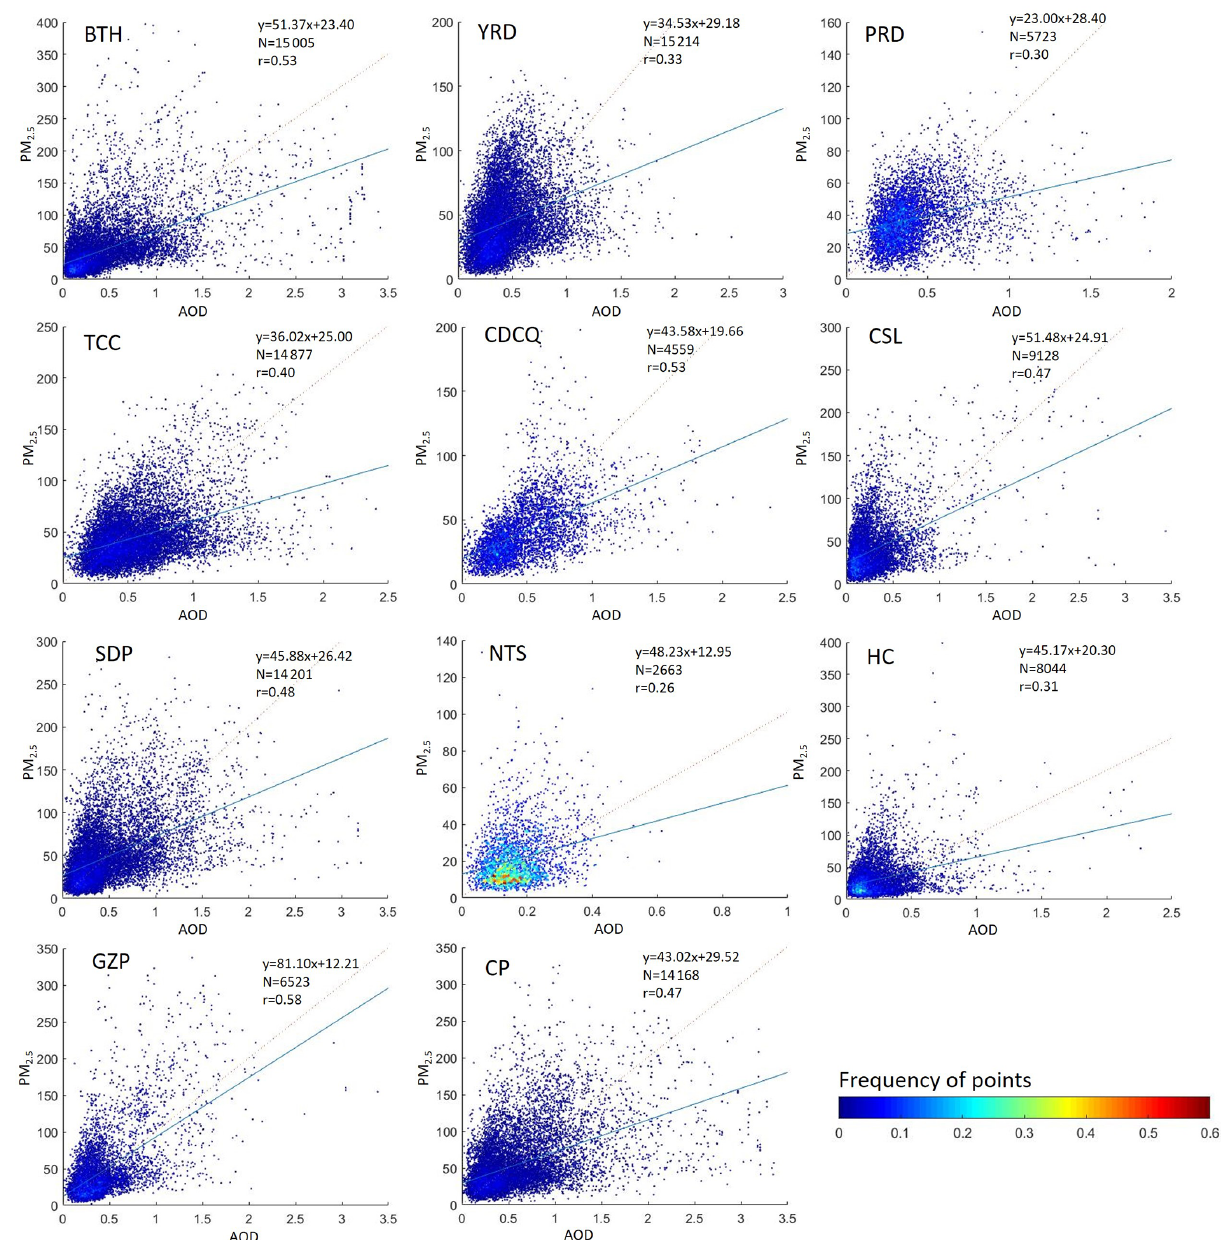
Figure 5. Scatterplots for the paired PM 2 . 5 concentration (µgm − 3 ) and satellite AOD values over the 11 urban agglomerations in China including Beijing–Tianjin–Hebei (BTH), Yangtze River Delta (YRD), Pearl River Delta (PRD), Triangle of Central China (TCC), Chengdu– Chongqing (CDCQ), central and southern Liaoning (CSL), Shandong Peninsula (SDP), Harbin–Changchun (HC), Central Plain (CP), Guanzhong Plain (GZP) and northern Tianshan (NTS). The solid line represents the linear